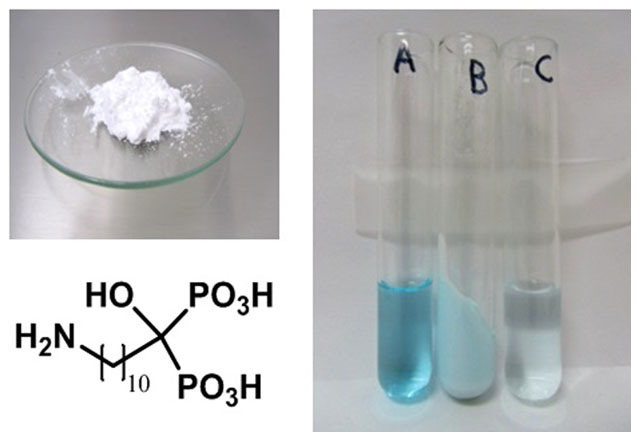
N10O (left picture and chemical structure under the picture) and illustration chelation of CuII with N10O.(A): 0.1 M CuCl2; (B): centrifuged and washed N10O with complexed CuII; (C): solution A after N10O treatment.